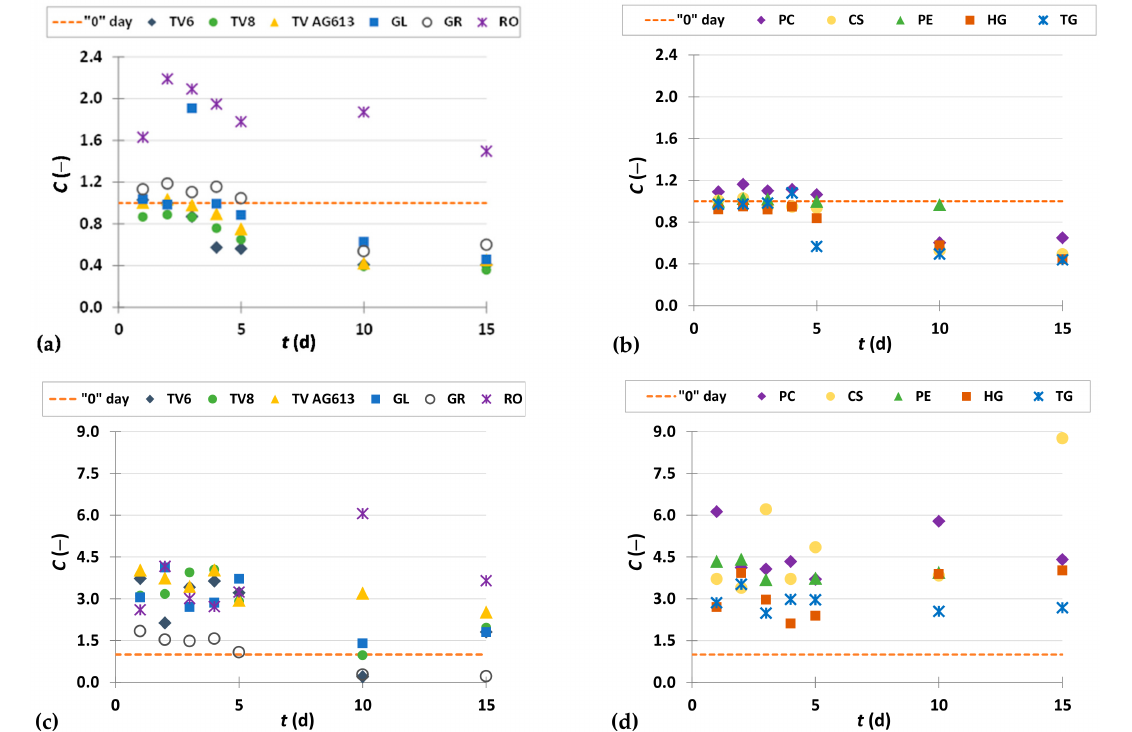
Figure 2. Dimensionless content ( C = C i / C o ) of gallic acid ( a , b ) and ellagic acid ( c , d ) in GP extracts before biological treatment (‘0’ day) and after 1–15 days of biological treatment with TV6, TV8, TV AG613, GL, GR, RO ( a , c ), and PC, CS, PE, HG, TG ( b , d ).